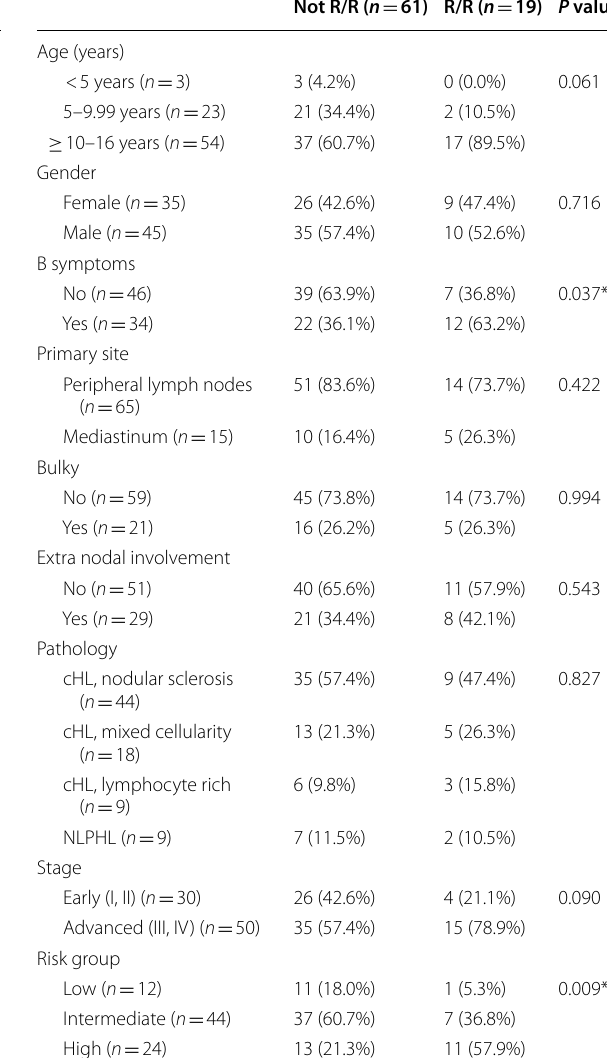
Table 3 Factors affecting the response to 1st line therapy Table 4 Factors affecting the relapse/refractory (R/R)